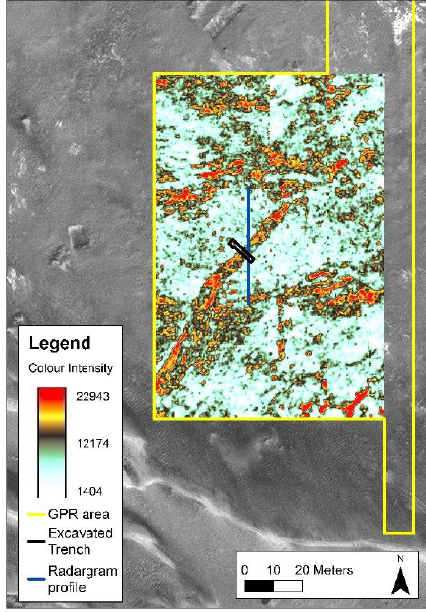
Figure 8. Ground Penetrating Radar (GPR) time slice color intensity image (with red representing high intensity and white representing low intensity) at 6.2–12.2 ns/44.5–89.1 cm depth with location of excavated trench and radargram profile.